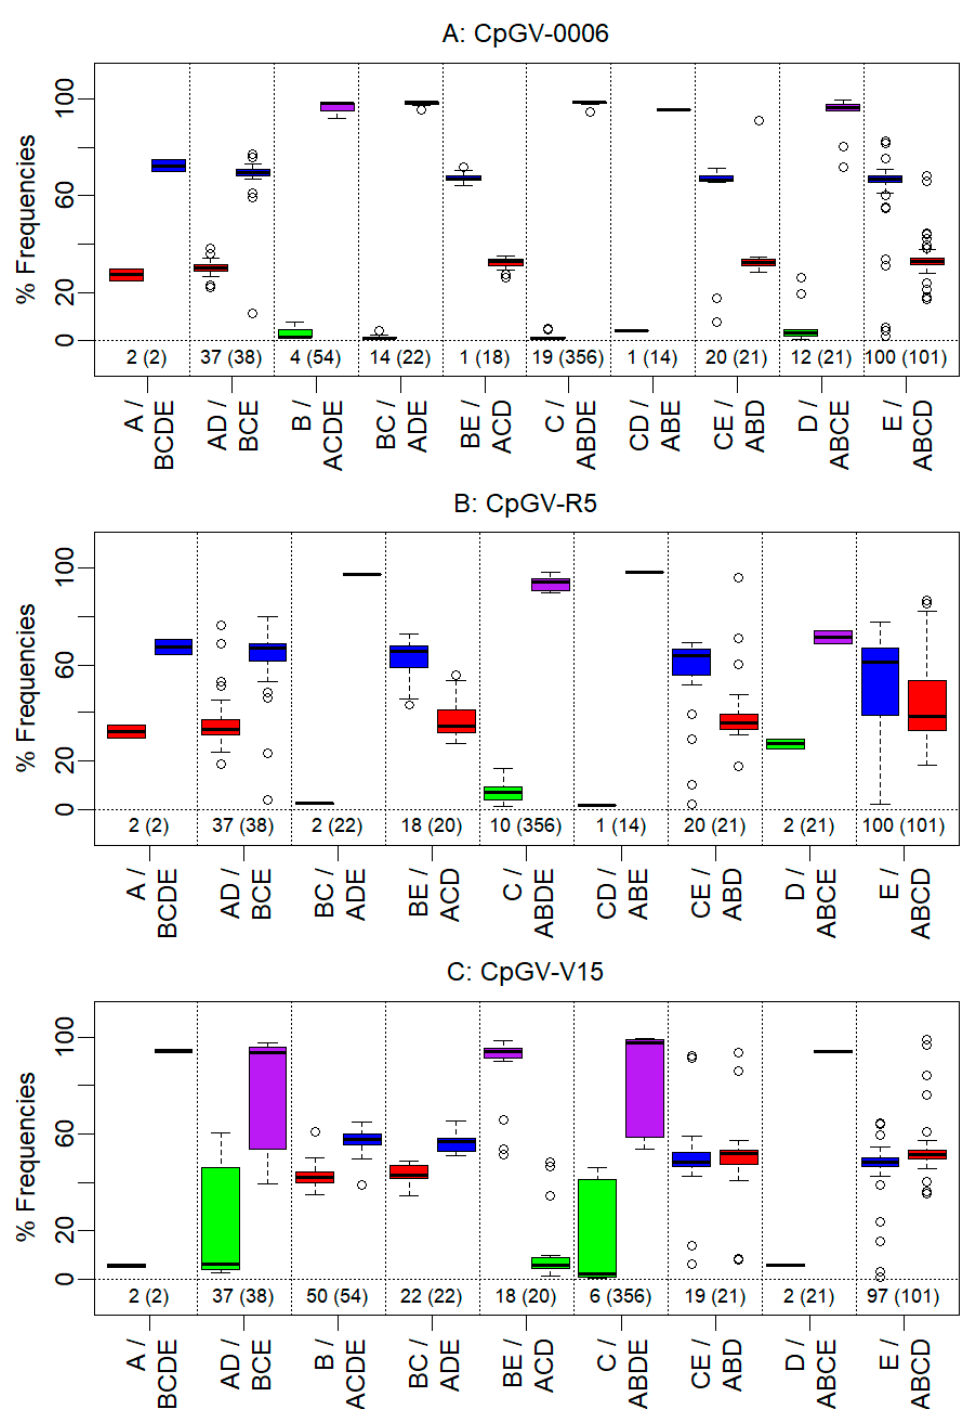
Figure 5. Frequencies (%) of SNP variants specific for one of the CpGV genome groups (A, B, C, D, E) or a combination of the genome groups in CpGV-0006 ( A ); CpGV-R5 ( B ) and CpGV-V15 ( C ). Given are the number of identified SNPs at the bottom line with all distinct possible SNPs in brackets, as well as box-whisker-plots with the median frequency of SNP variants given as lines and outliers as circles.